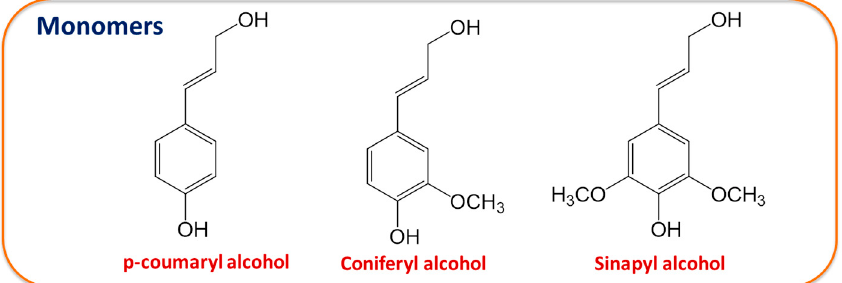
Figure 1. The three monomer building blocks of lignin.